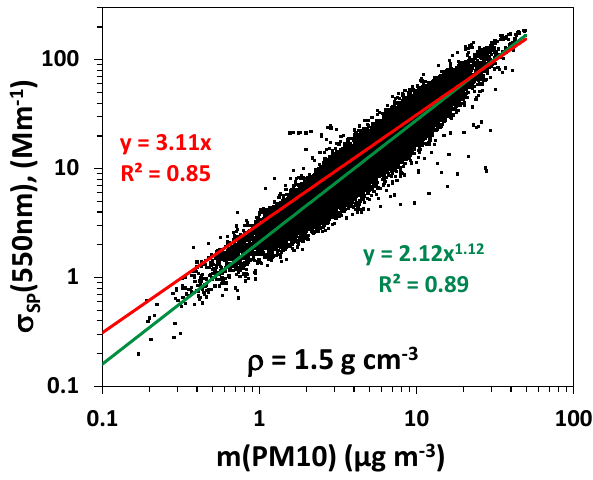
Fig. 8. Relationship of light scattering coefficient at λ = 550nm and aerosol mass concentration ( D p < 10µm) during the whole mea- surement period.